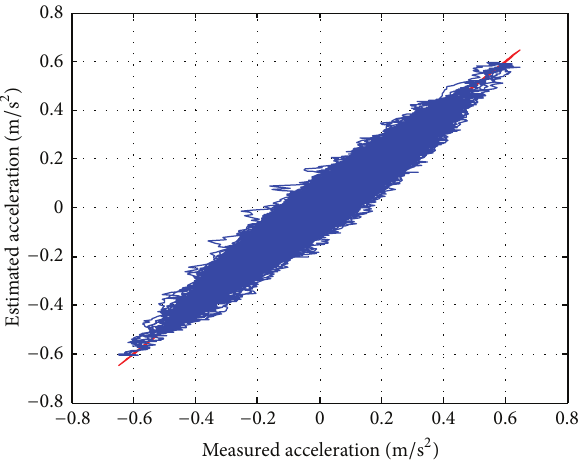
Figure 10: Correlogram between the measured and estimated acceleration for Case 1 (correlation coefficient = 0.965).